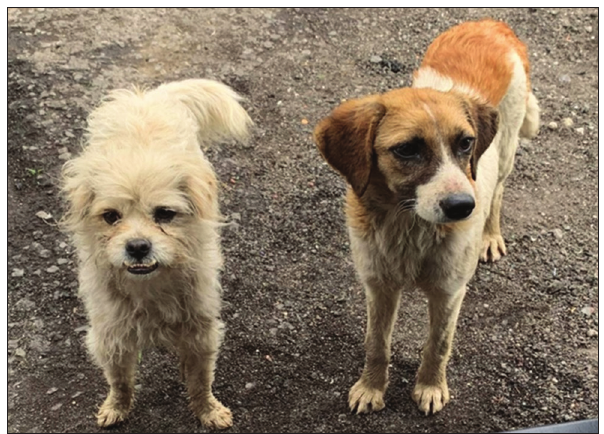
Figure-2: A stray dog with severe skin issues caused by demodicosis (Scabies). Note the areas with erythema and